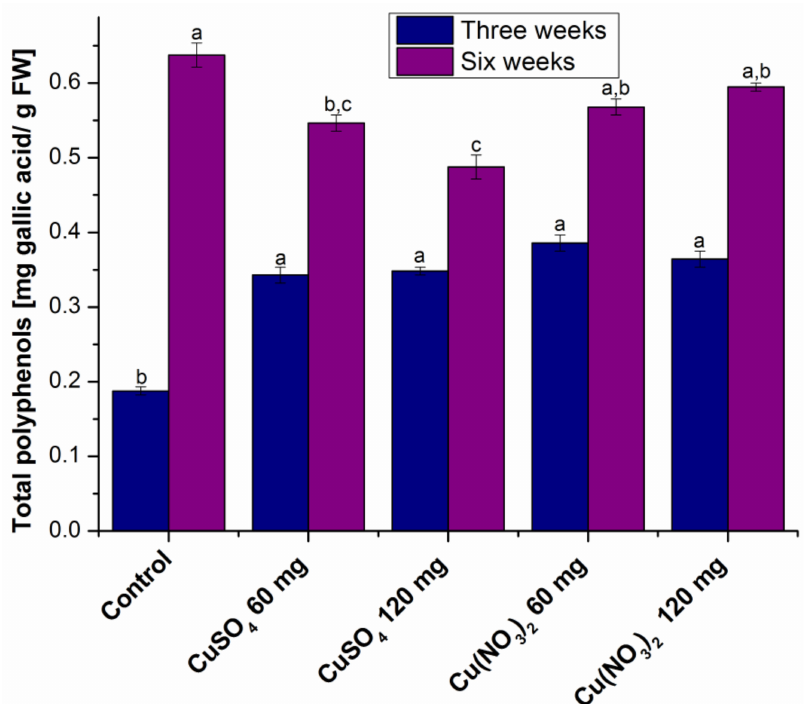
Figure 2. Comparative diagram of the total amount of polyphenolic compounds. Each data point is the mean ± the standard error of the mean of three independent replicate experiments; different letters mean significant differences between the treatment and the control plants, as determined by Tucky’s test ( p < 0.05).